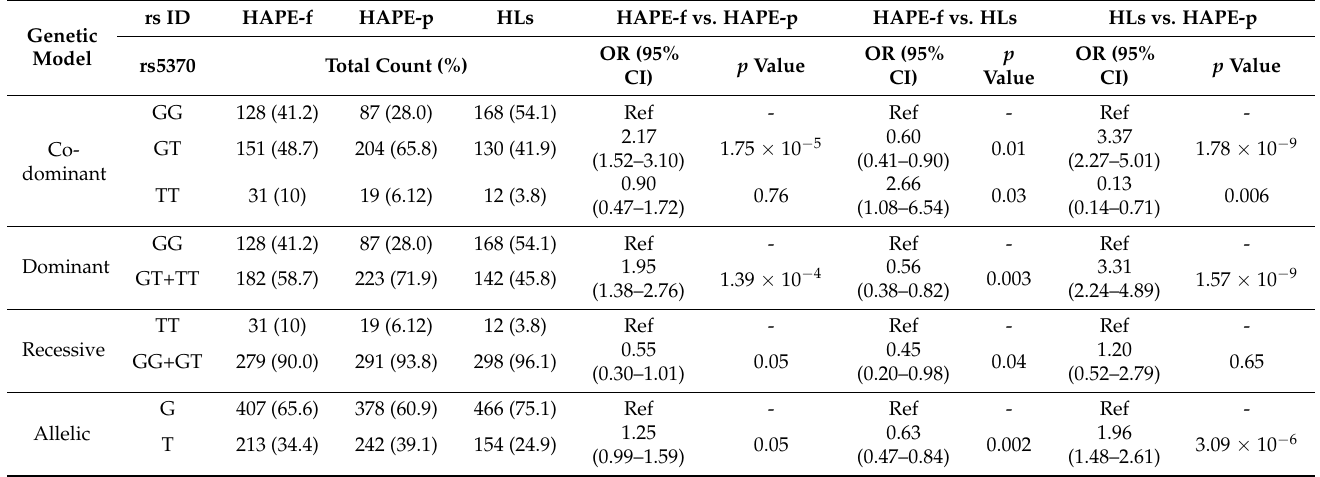
Table 1. Genotype and allele distribution of the polymorphism rs5370 of EDN1 in HAPE-f, HAPE-p, and HLs.